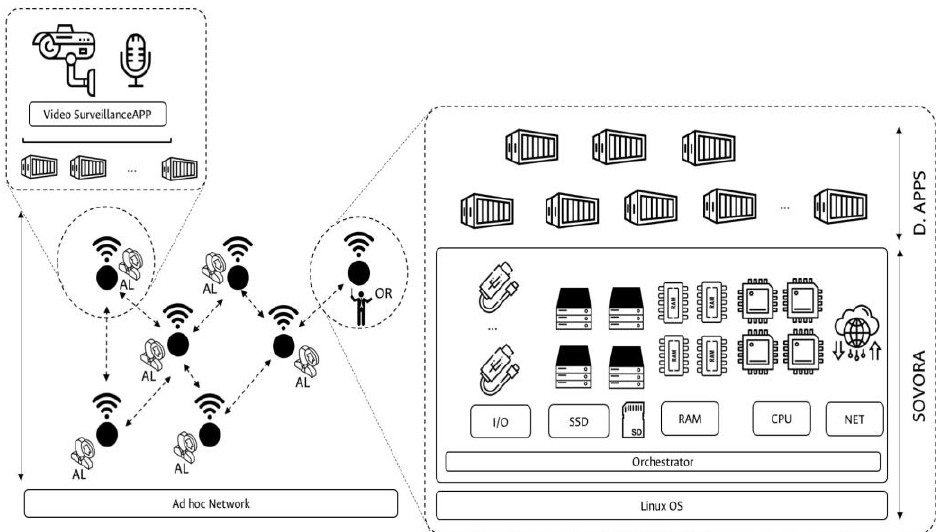
Figure 6. Experiment Model.